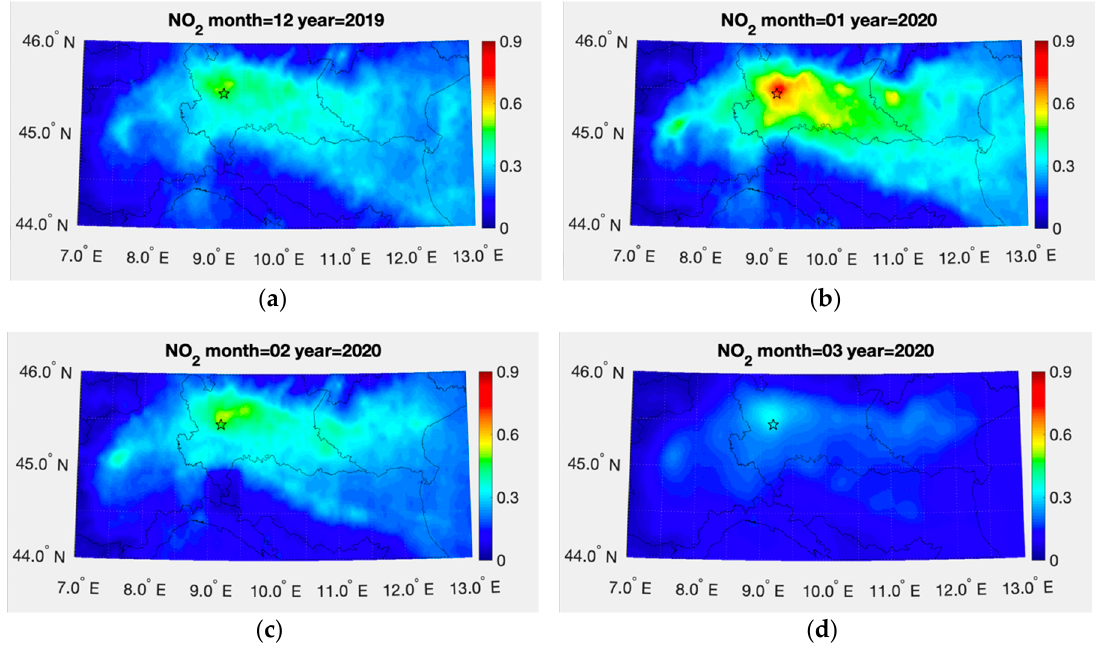
Figure 18. Monthly NO 2 pollution, as revealed by TROPOMI for the period December 2019-March 2020. In particular, December 2019 ( a ) and January ( b ), February ( c ), March ( d ) 2020.